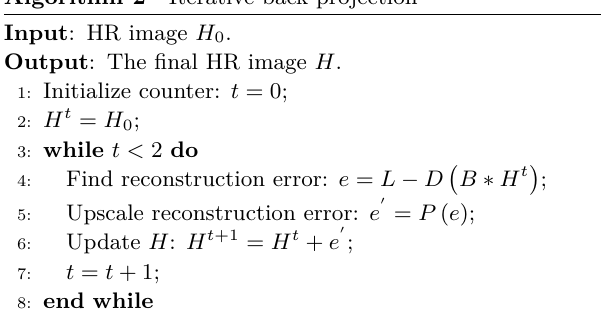
Algorithm 2 Iterative back-projection